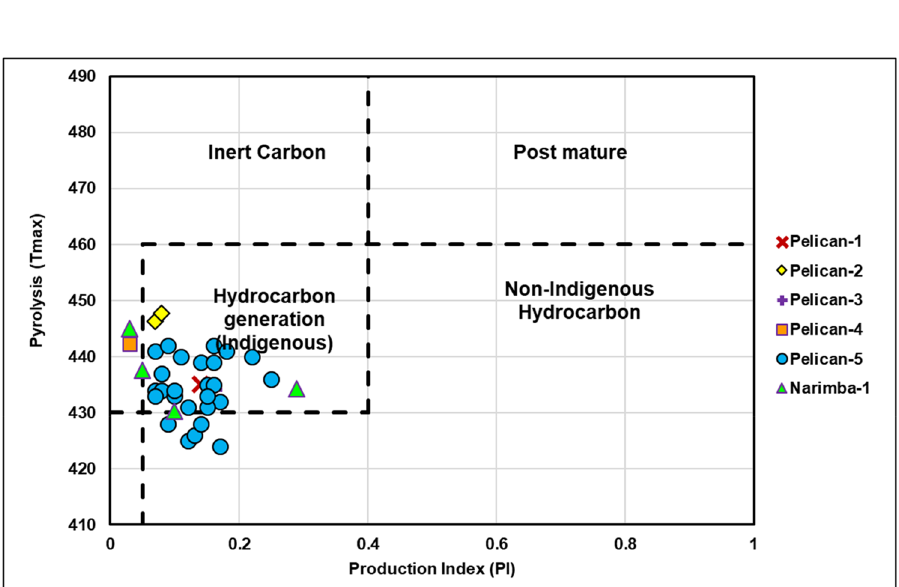
Fig. 11 T max versus PI for further indication of thermal